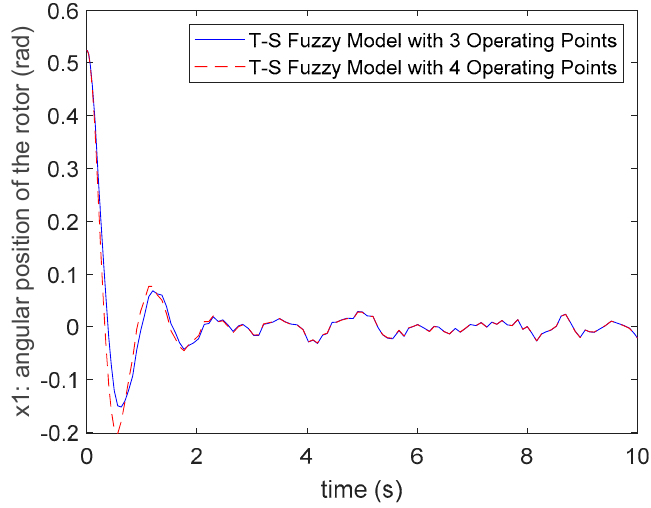
x t responses for Case 1. 1